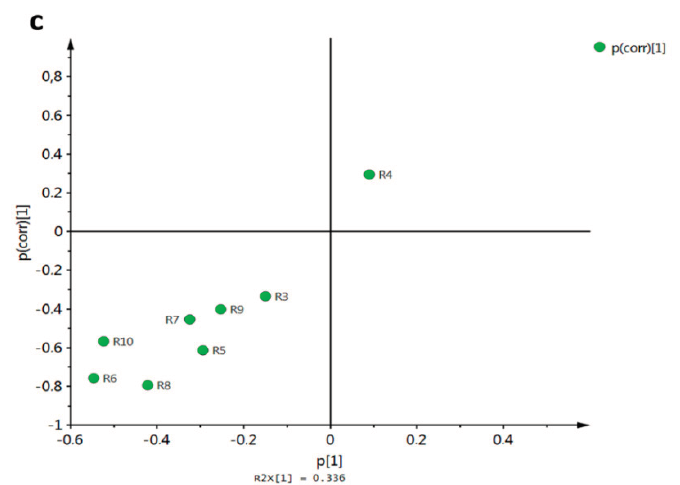
Figure 17. Discrimination of simple xanthones by antifungal activity against M. canis and E. floccosum based on docking scores ( a ) PCA score plot grouped according to HCA; ( b ) OPLS-DA score plot employing antifungal activity as classification variable (group 1: high to medium activity; group 2: low to absent activity); ( c ) S -plot from OPLS-DA.